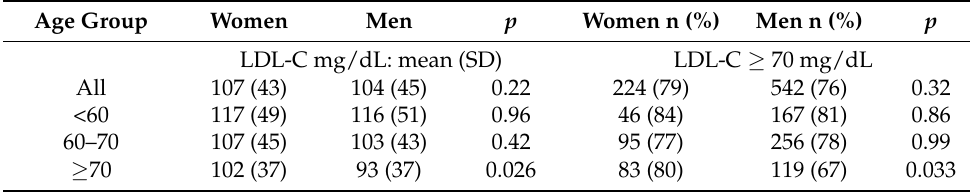
Table 2. Lipid profile according to gender and age at